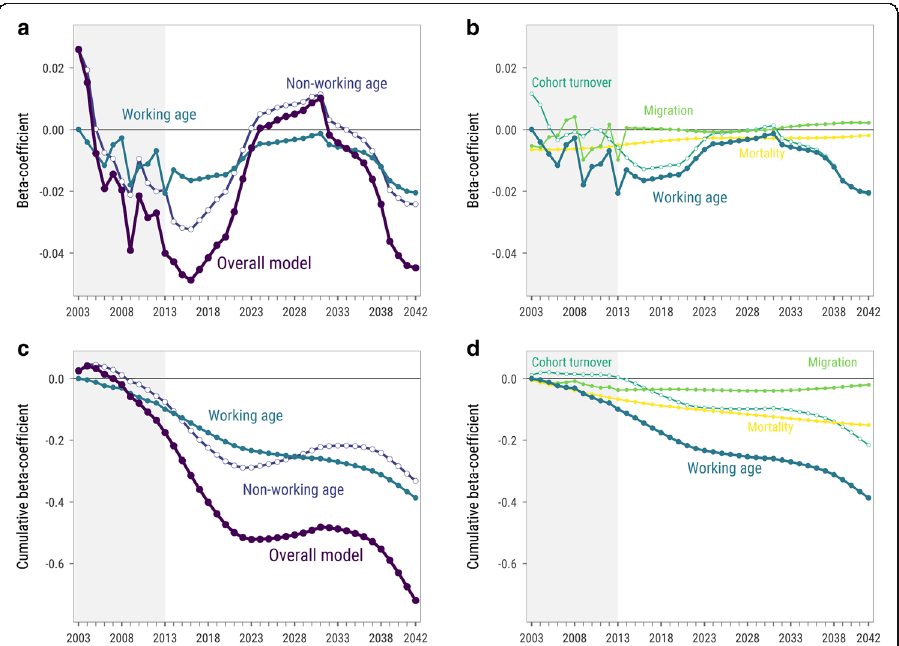
Fig. 5 Bi-dimensional decomposition of beta-convergence estimates by (1) component of change in TSR and (2) time. Notes : Each point represents beta coefficient from the corresponding partial model. The left panels show the first step of TSR growth decomposition; the right panels shows the second step. Panels a and b show beta-convergence estimates for each year separately; panels c and d show the cumulative effect. Observed period marked with a light-gray